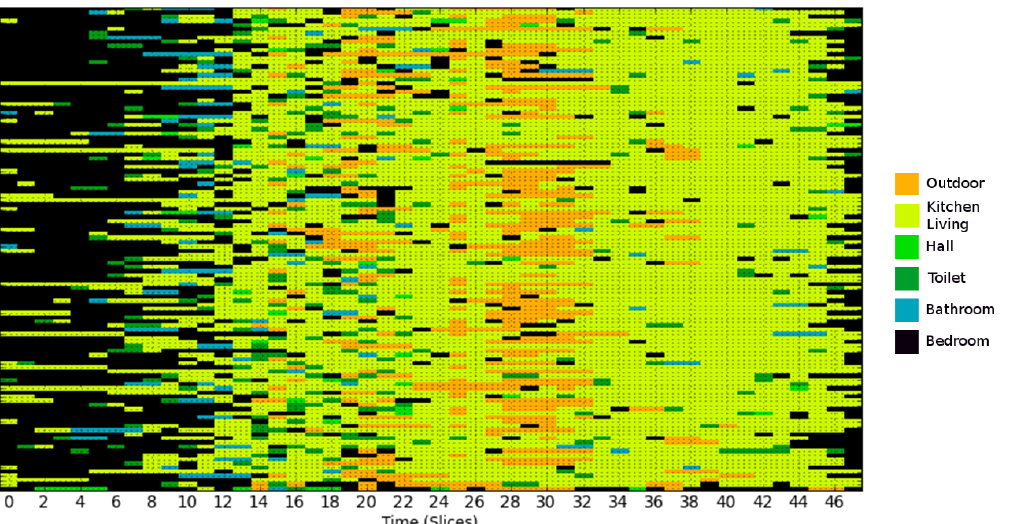
Figure 6. Location heat map for real data with a 30-min resolution. This low resolution is for visualization purposes; normally, resolution is much higher (e.g., 60